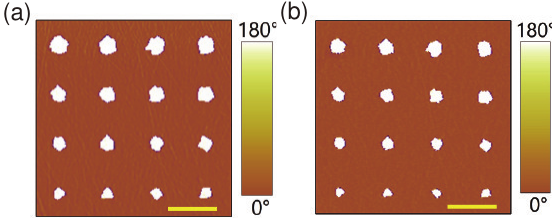
Figure 5. Thermal stability of the dot domains in a sample that underwent a pre-heat treatment at T p = 150 ◦ C for 2 h. ( a ) PFM images of as-written dot domains with different diameters before the thermal annealing treatment. ( b ) PFM images of dot domains after the thermal annealing treatment at 120 ◦ C for 1 h. Here, the dot domains in each row were fabricated at the same AFM-tip voltage as those in Fig. 3. The scale bar is 1 µ m in all figures.